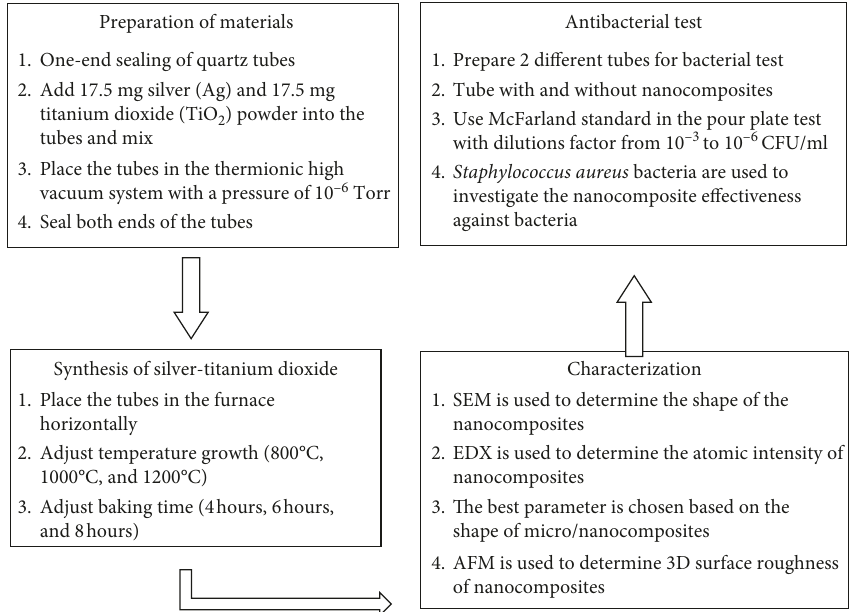
Figure 3: A detailed flowchart of the study.